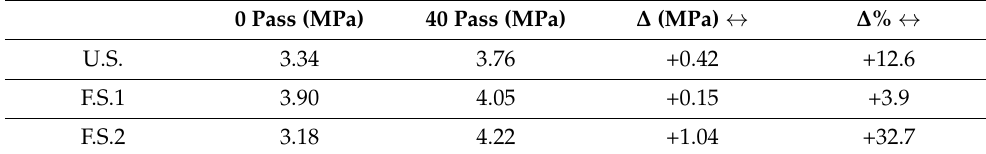
Figure 3. Comparison of the penetration resistance (MPa) development at a particular number of machine passes by a universal skidder Zetor 7245 ( a ), forest skidder LKT 81 ITL ( b ), and forest skidder HSM 805 HD ( c ), and average soil penetration resistances (MPa) caused by machine traffic, with vertical lines depicting 95% confidence intervals ( d ). Black bar color (subfigures ( a – c )) indicates a decrease in penetration resistance. Table 7. Penetration resistance (MPa) observed at the control measurement and the ultimate machine pass over the skid trails; U.S.—Zetor 7245, F.S.1—LKT 81 ITL, F.S.2—HSM 805 HD. 0 Pass